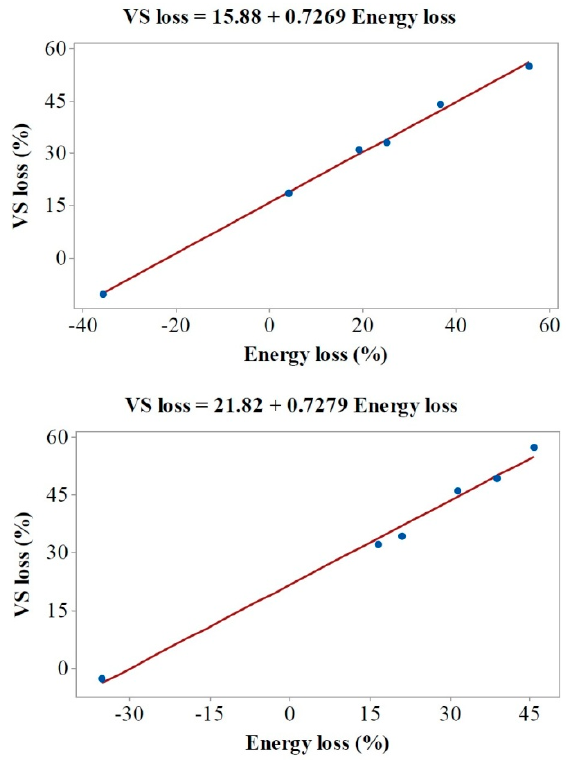
Figure 2. Energy losses versus VS losses for open silo ( top ) and closed silo ( bottom ).